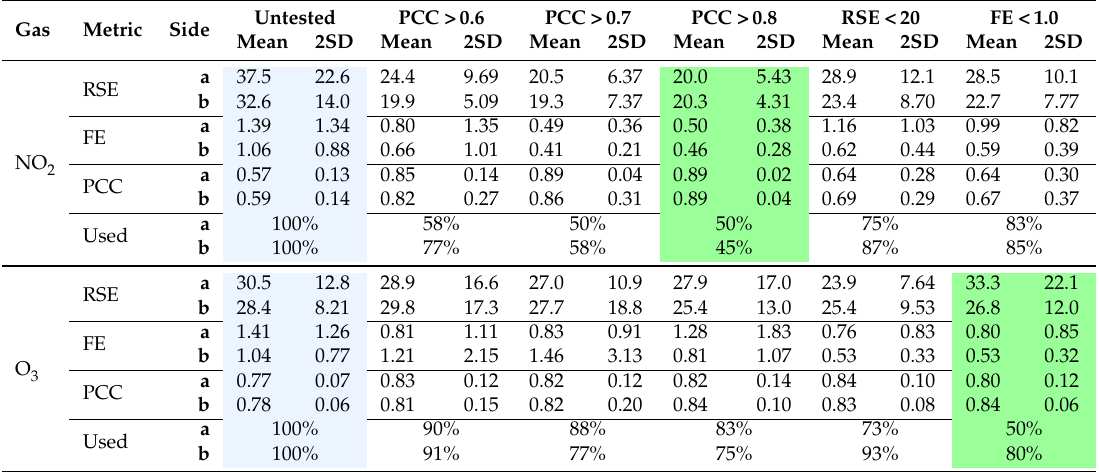
100% 82% 78% 56% 75% 42% Table 3. Table of means and 95% confidence intervals for goodness tests across a month-long span. The shorter period results in higher precision and accuracy. For correlation, a higher mean score is better. For FE and RSE, a lower mean is better. Low 95% confidence intervals (2SD) are better all